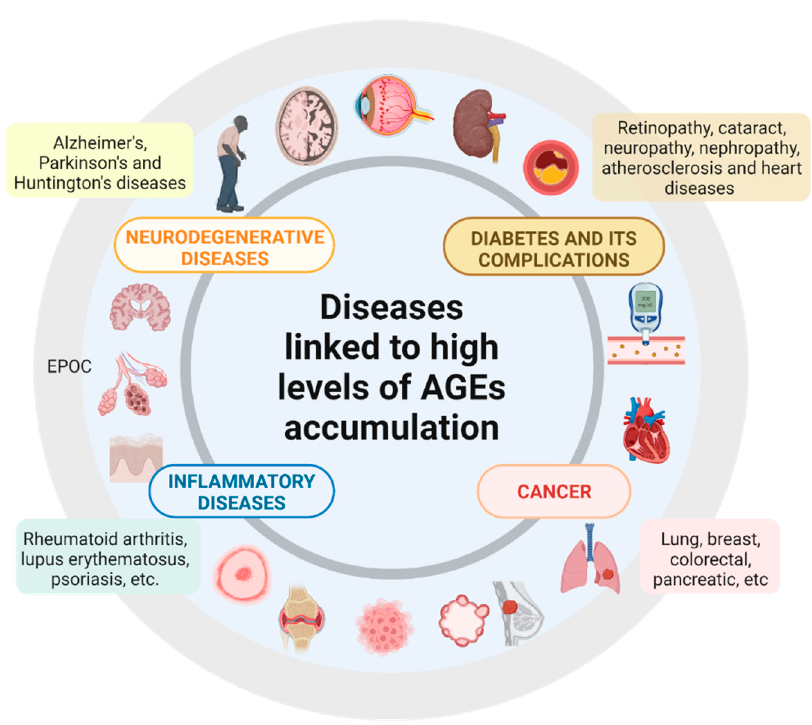
Figure 2. Diseases linked to high levels of AGEs accumulation. The excessive formation or accu- mulation of AGEs and their interaction with RAGEs contribute to the pathogenesis and development of diabetic complications, different kinds of cancer, and neurodegenerative and inflammatory diseases. Created with BioRender.com.